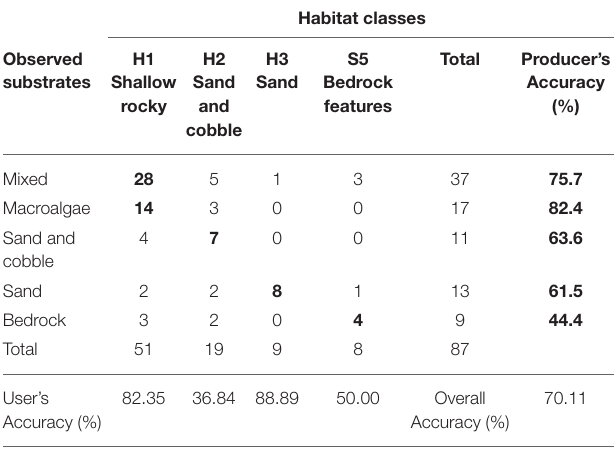
TABLE 1 | Eastport Marine Protected Area habitat map error matrix ( N =